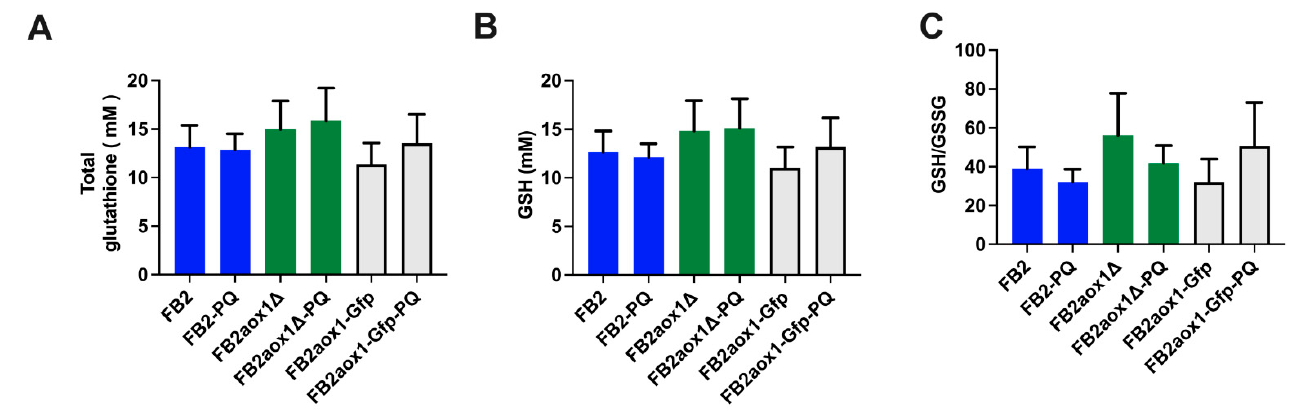
Figure 5. Determination of glutathione. Cells were incubated for 4 h in the presence or absence of 1 mM PQ. Then, the total glutathione (GSH + GSSG) was determined as described in the Materials and Methods. ( A ) Total glutathione, ( B ) GSH, ( C ) GSH/GSSG ratio. The bars represent the error standard of at least four independent experiments ( n = 4). One-way ANOVA analysis was performed to detect significant differences between means using p < 0.05.